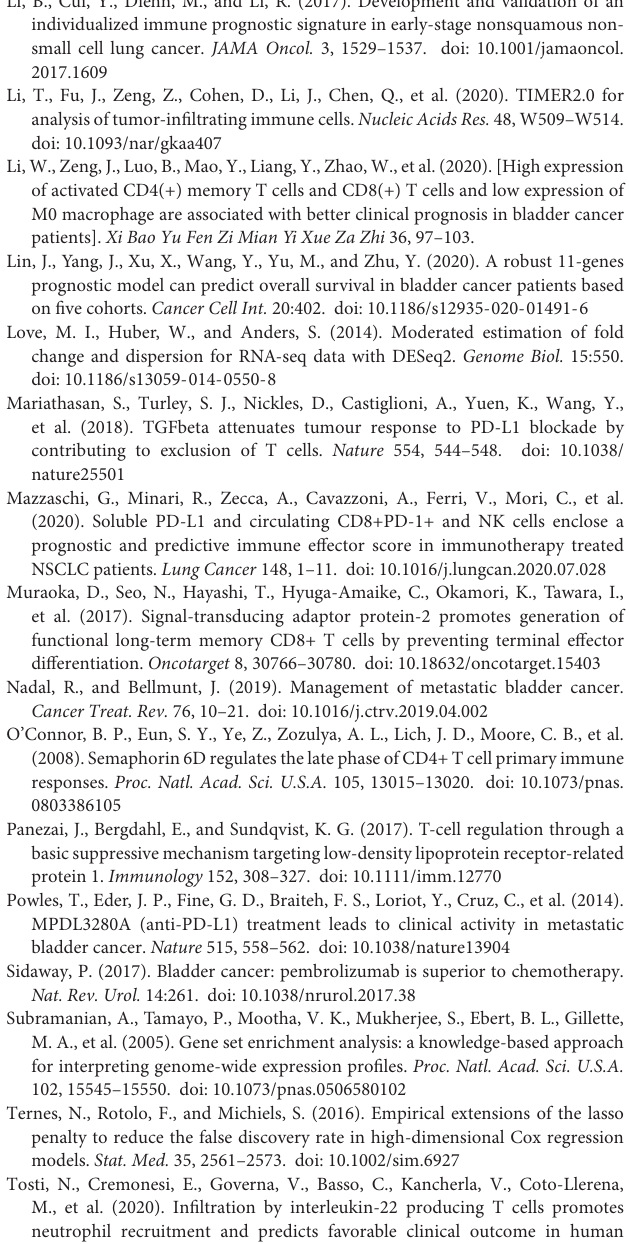
Supplementary Figure 1 | Distribution of each DEIG in TCGA set and ICI treatment set. Supplementary Figure 2 | Kaplan–Meier curve of each DEIG in TCGA